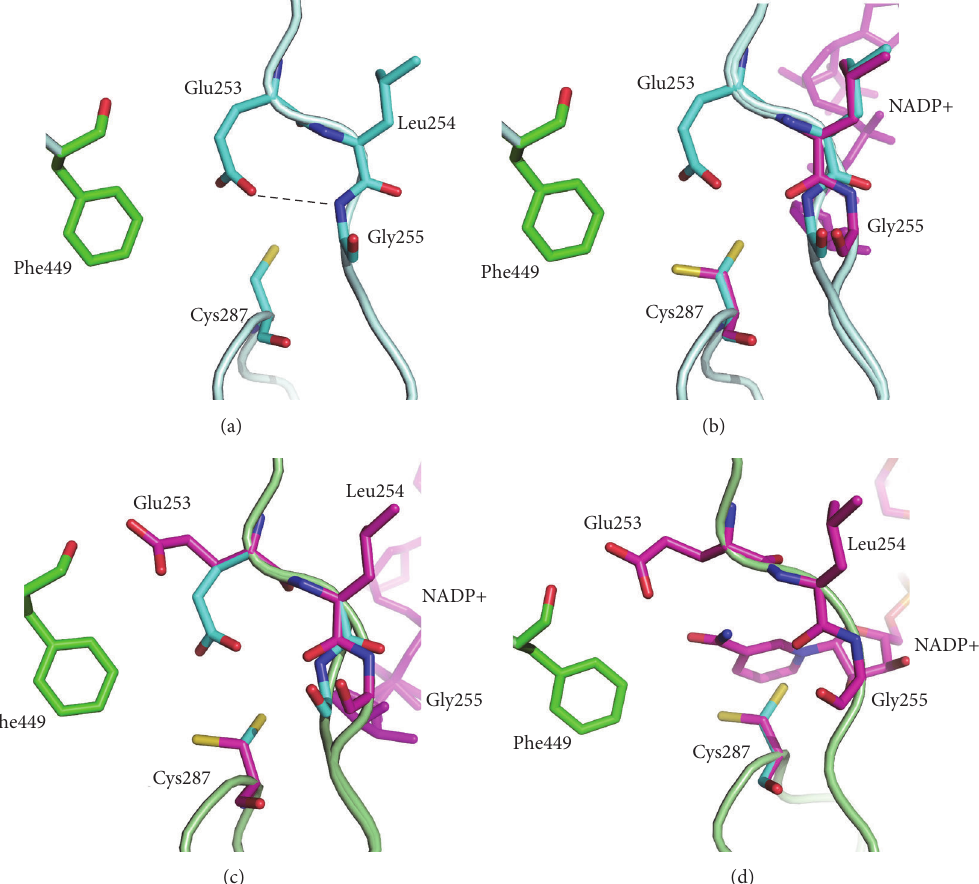
Figure 4: Conformations of the active site residues in (a) the apo form, (b) Holo-1, (c) Holo-2, and (d) Holo-3. The coenzyme is in magenta. When the coenzyme is present in the active site, the Glu253, Cys287, and Gly255 residues are in conformations shown in magenta. When there is no coenzyme in the active site, the Glu253, Cys287, and Gly255 residues are in conformations shown in cyan. Hydrogen bonds are shown by dashed